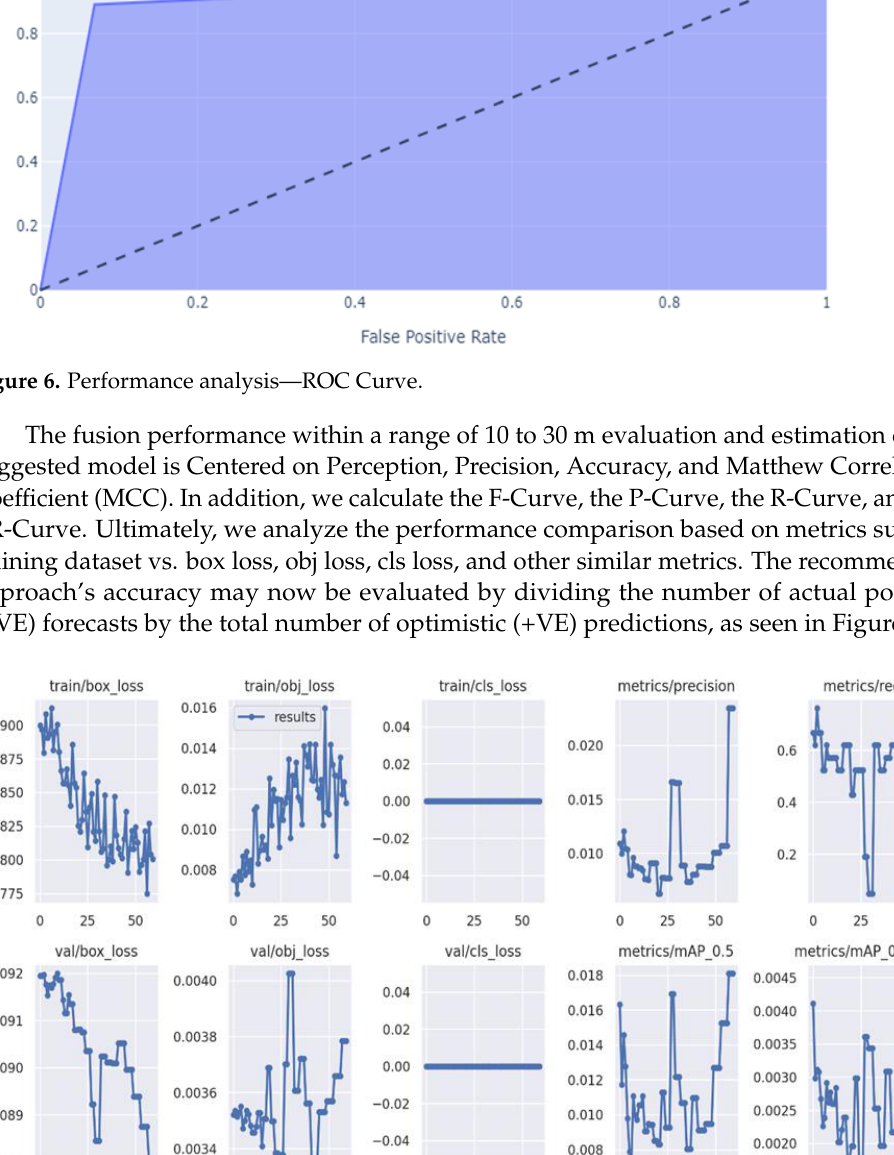
Figure 7. Overall performance indicators.